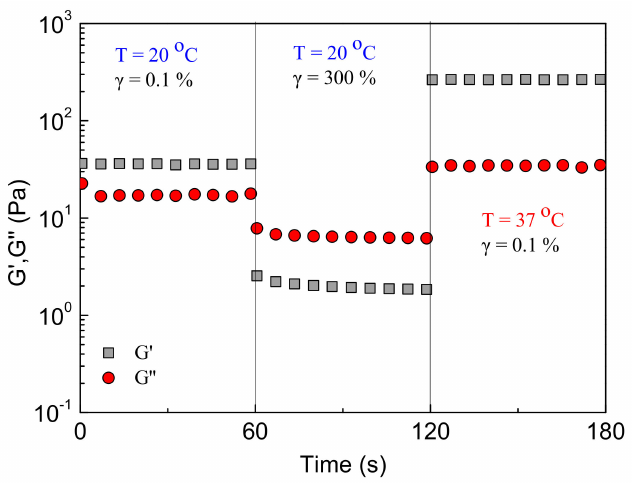
Figure 11. Time dependence of G’ (squares) and G” (circles) at 1 Hz, under different condi- tions of temperature and strain amplitude, as indicated, for the 4 wt % NaALG- g -P(NIPAM 80 - co -NtBAM 20 )/DMEM